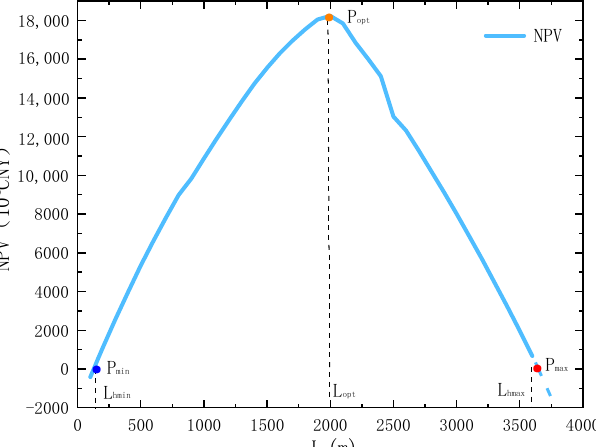
Figure 5. Relationship curve between the NPV and the lateral length when the half-length of the fracture is 300 m.